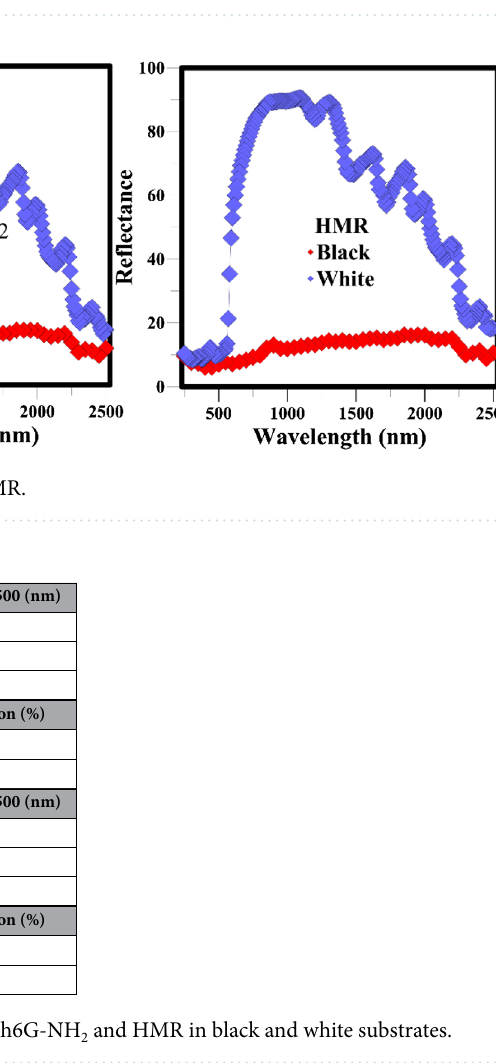
Figure 8. Fluorescence microscopy images of COUM, MOHCYAA, Rh6 G, Rh6G-NH 2 , and HMR.